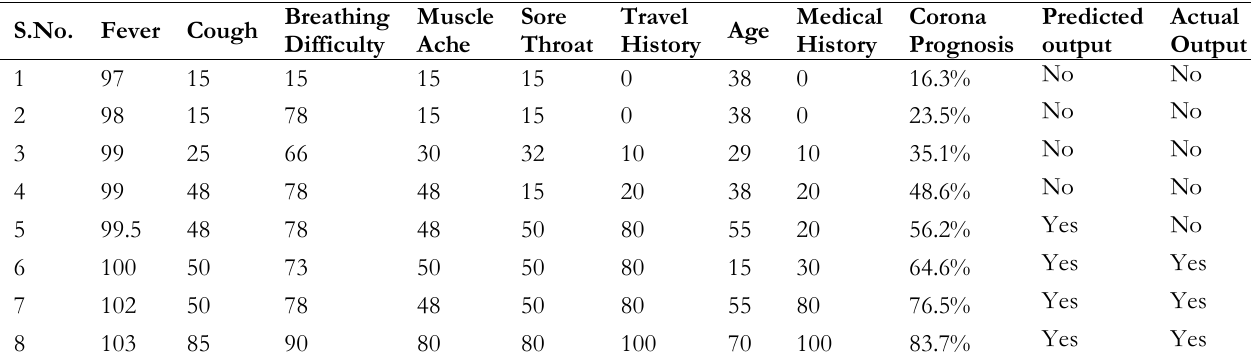
Fig. 7. Surface view with different inputs. Table 5. A few predicted corona prognosis.